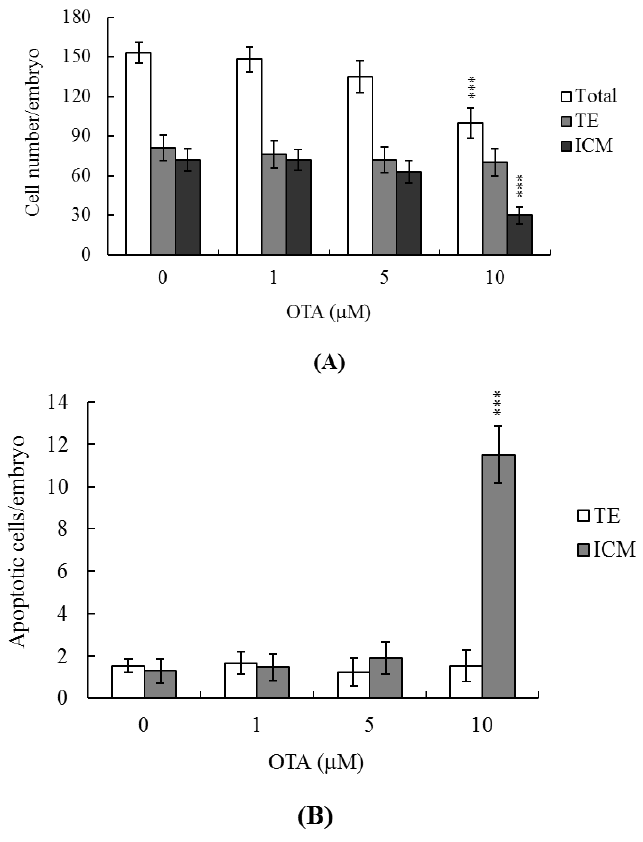
Figure 2. Effects of OTA on blastocyst viability. Mouse blastocysts were treated with OTA (1, 5, or 10 μM) for 24 h, or left untreated. ( A ) The total number of cells per blastocyst, and the numbers of cells in the inner cell mass (ICM) and the trophectoderm (TE) were counted; ( B ) The proportions of Annexin V-positive/PI-negative cells in the blastocysts of each group were determined. Data are based on at least 230 blastocysts from each group. Values are presented as means ± SEMs of five separate experiments. *** p < 0.001 versus the control